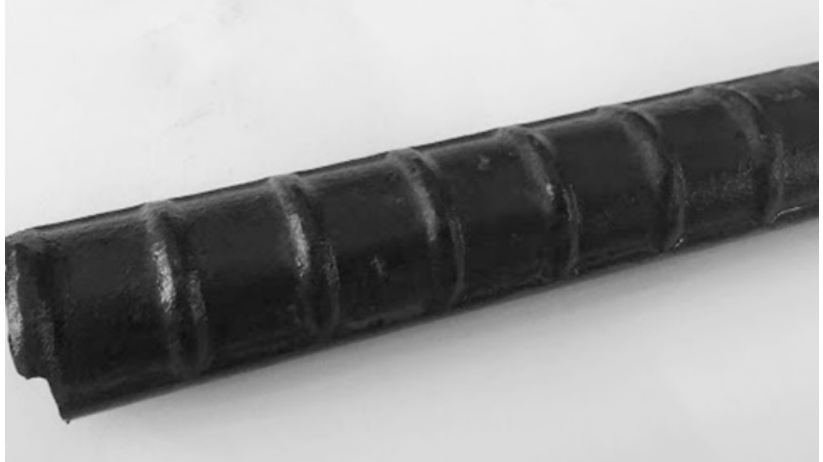
Figure 3. Visual aspect of deformed steel bar.